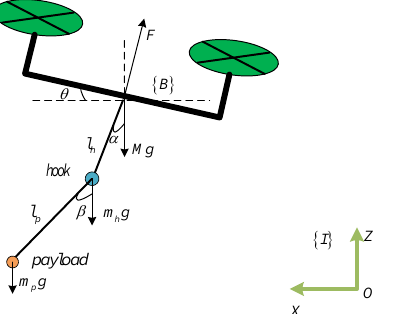
Figure 1. Dynamic model of double-pendulum quadrotor transportation